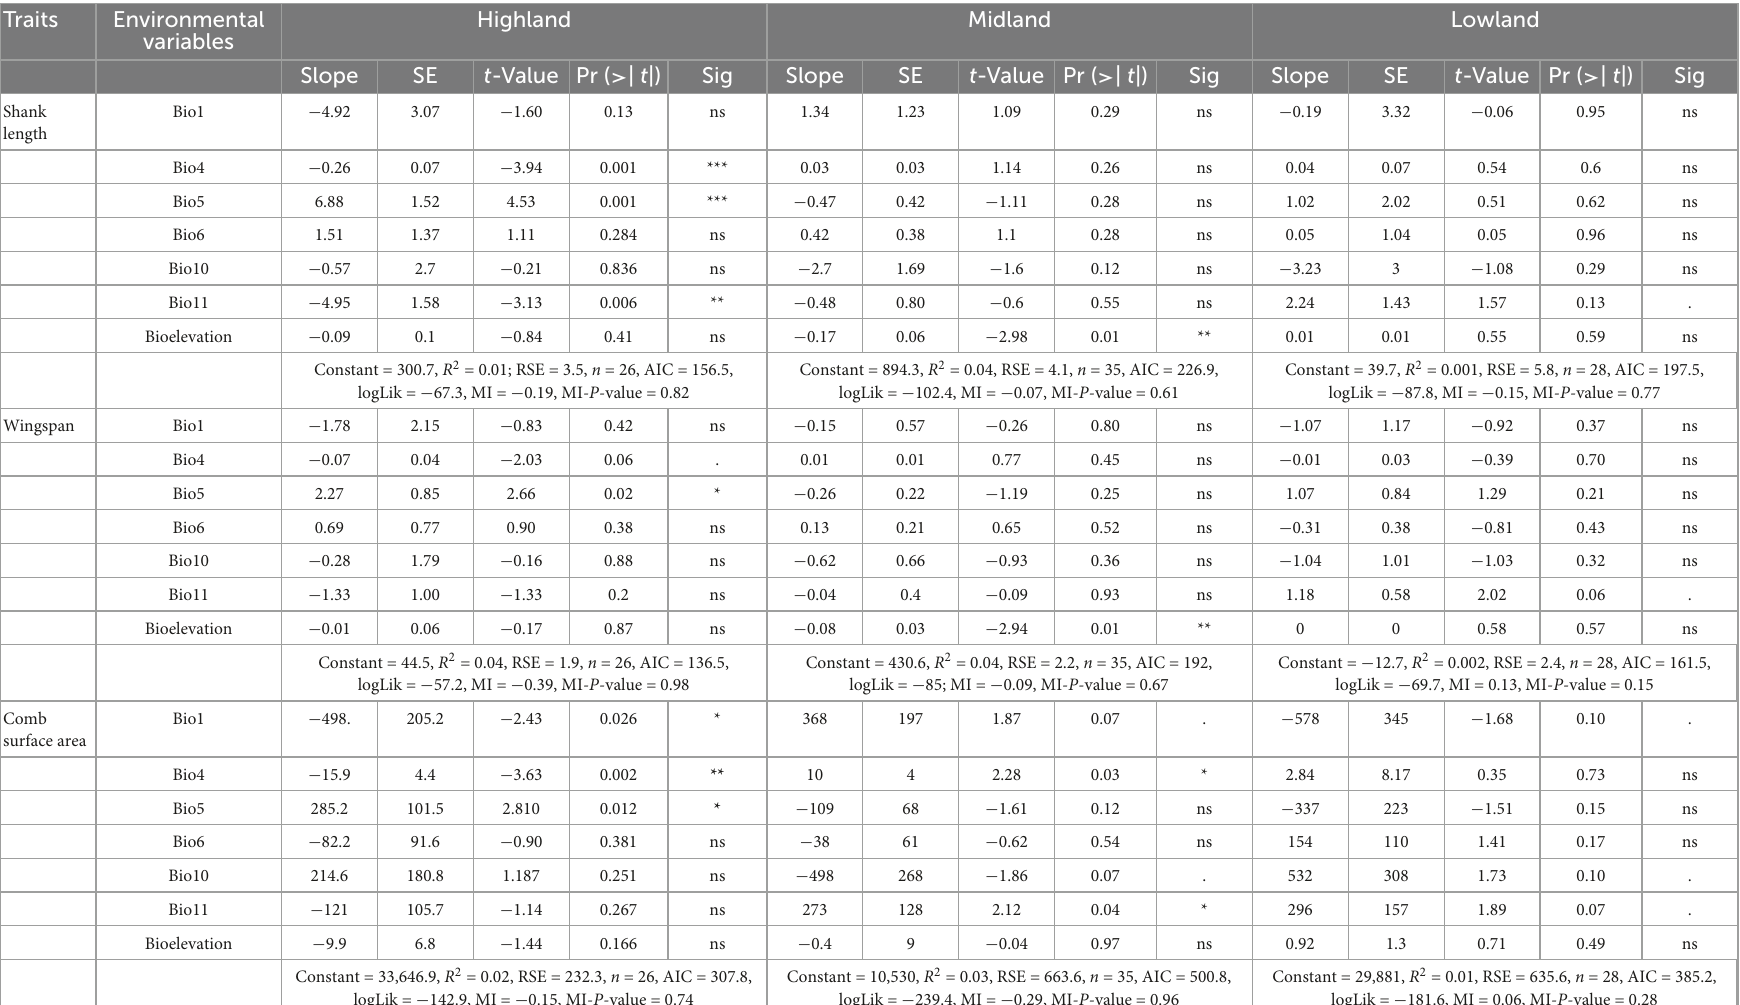
TABLE 4 Relationships (multiple linear regression) between male chicken appendages and environmental variables (Allen’s rule). Traits Environmental Highland Midland Lowland variables